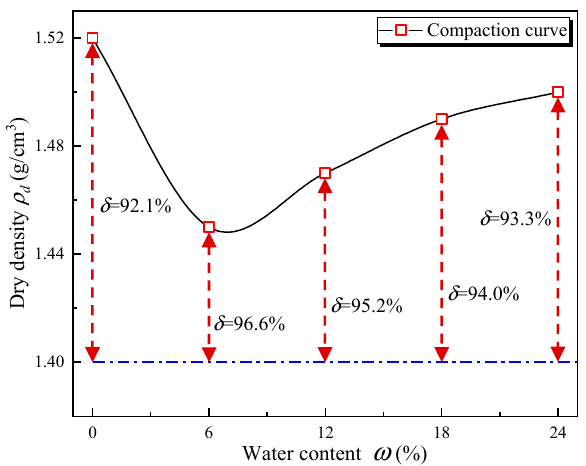
Figure 7. Compaction curve of coral gravelly sand.